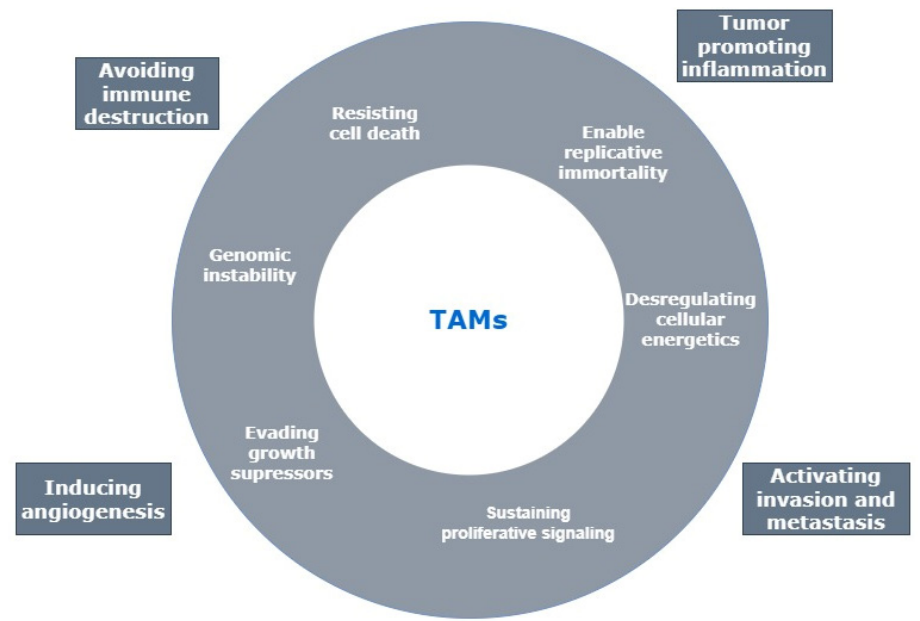
Figure 2. Major role of tumor associated macrophages (TAMs) in the hallmarks of cancer. Adapted